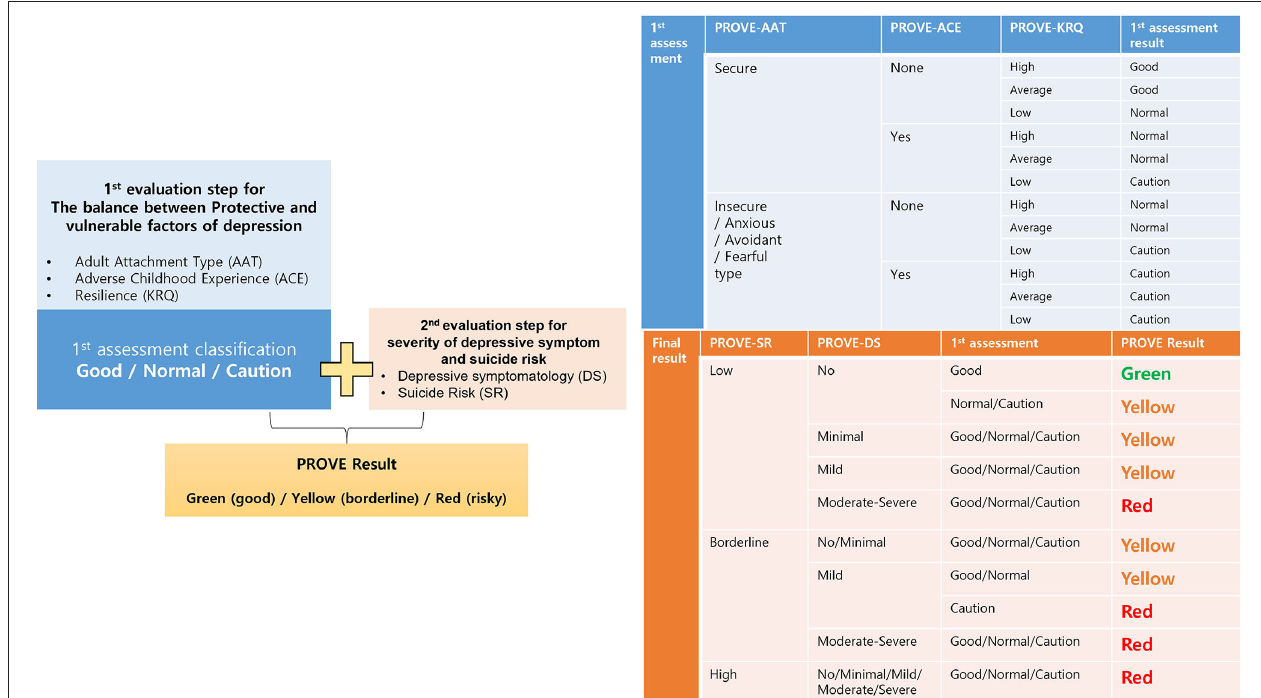
FIGURE 2 | Flow chart summary of the analysis of results of the PROtective and Vulnerable factors battEry questionnaire (PROVE) battery. The first assessment is based on protective and vulnerable factors of depression, and these results are combined with the current depression, and finally, the participants are divided into the following three groups: good (green) /borderline (yellow)/risky (red). The tables next to it describe the detailed logic from which each process is derived. PROVE, PROtective and Vulnerable factors battEry questionnaire; AAT, adult attachment type; ACE, adverse childhood experience; KRQ, Korean resilience quotient; DS, depressive symptomatology; SR, suicide